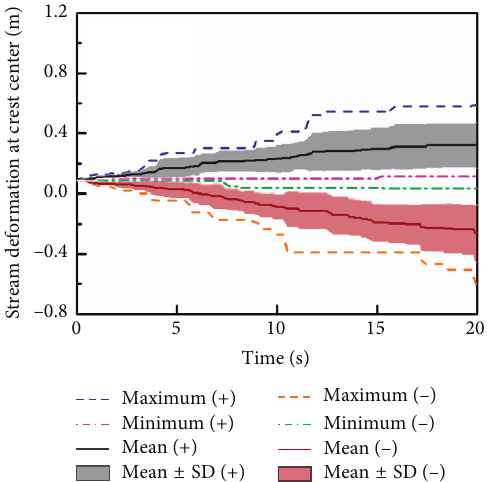
Figure 14: The stream deformation at the crest centre under earthquakes of different intensities.